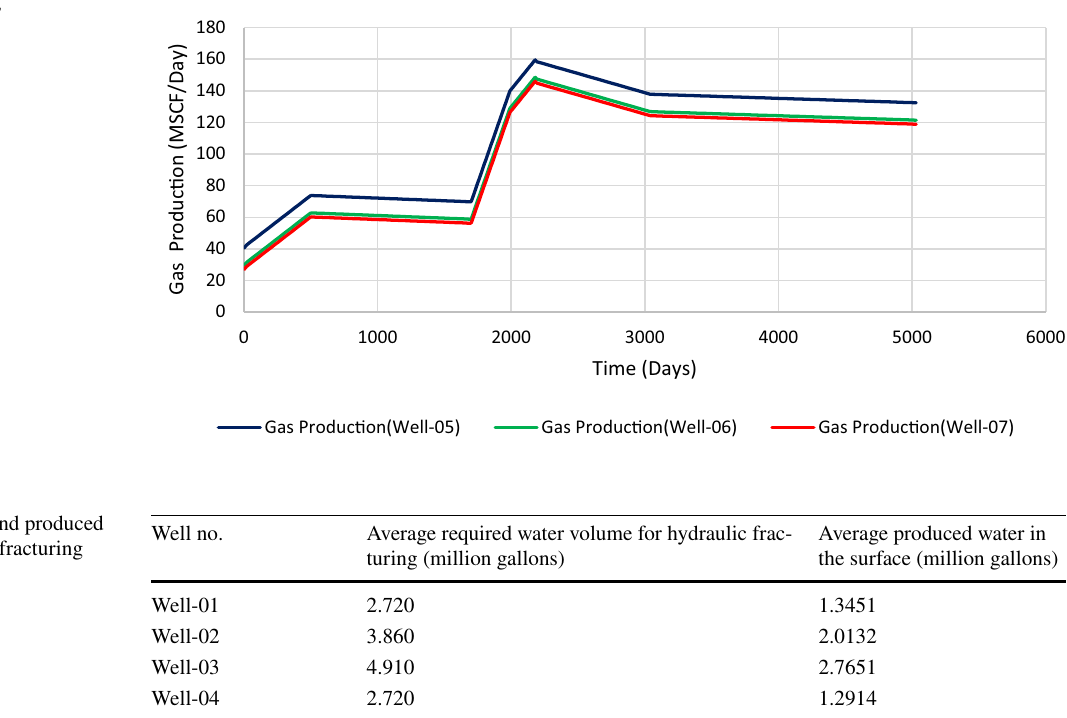
Table 6 Required and produced water for hydraulic fracturing